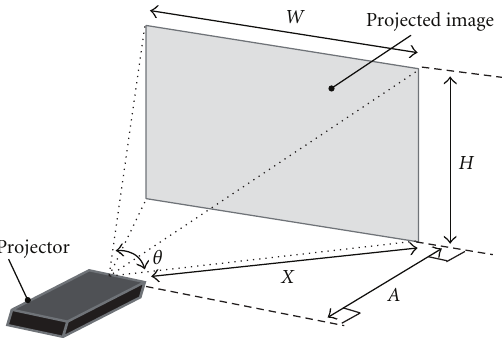
Figure 10: Configuration of projected